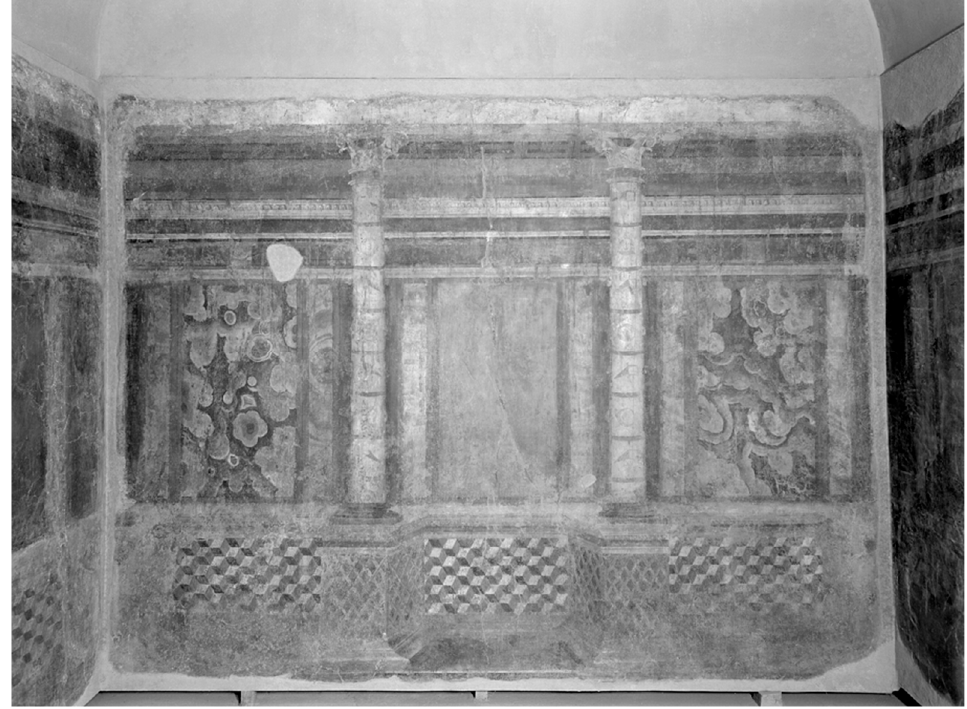
Figure 16. Early second-style wall from the Casa dei Grifi (room II); © DAI Rome, D-DAI-ROM-66.8.